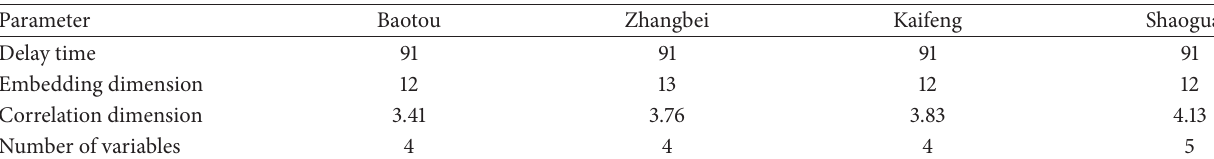
Table 3: Results of reconstruction parameters of reference evapotranspiration series.